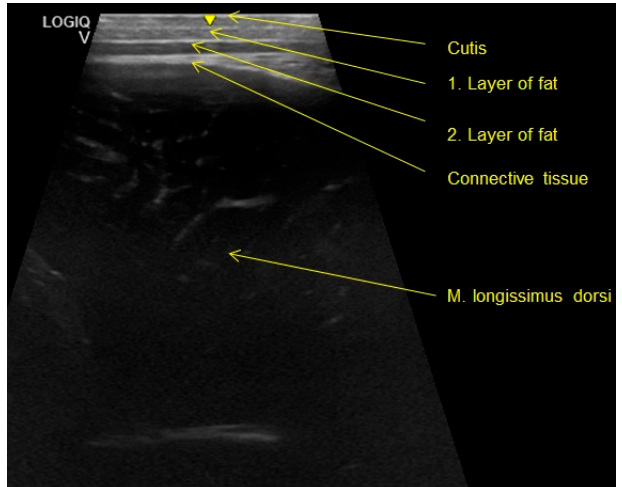
Figure 4. Ultrasound image taken in these examinations in order to illustrate the layers mentioned (photo: © Reckels, University of Veterinary Medicine, Hanover).